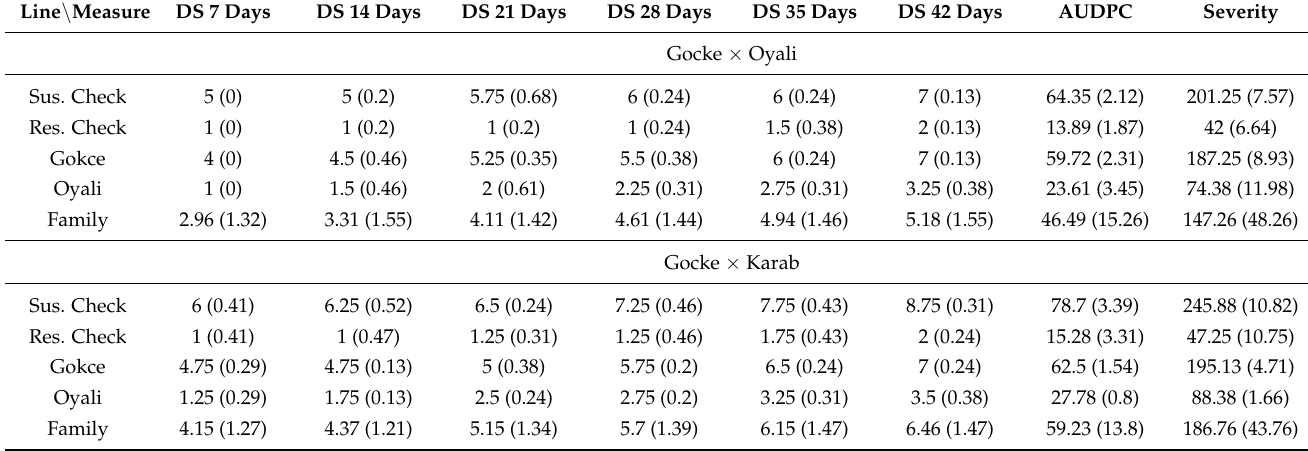
Table 1. Summary Ascochyta resistance measures for the chickpea Gokce × Oyali and Gokce × Karab families and check lines. Notes: Lines are the susceptible check (Sus. Check), the resistant check (Res. Check), both parental lines of each family, and the family. Sample sizes were four replicates for each check and parent, 160 lines for the GO family, and 144 lines for the GK family. Measures are disease scores (DS) at each number of days after inoculation, severity, and area under the disease progress curve (AUDPC). Measures were adjusted for block effects using augmented design. Means are followed by standard deviations in